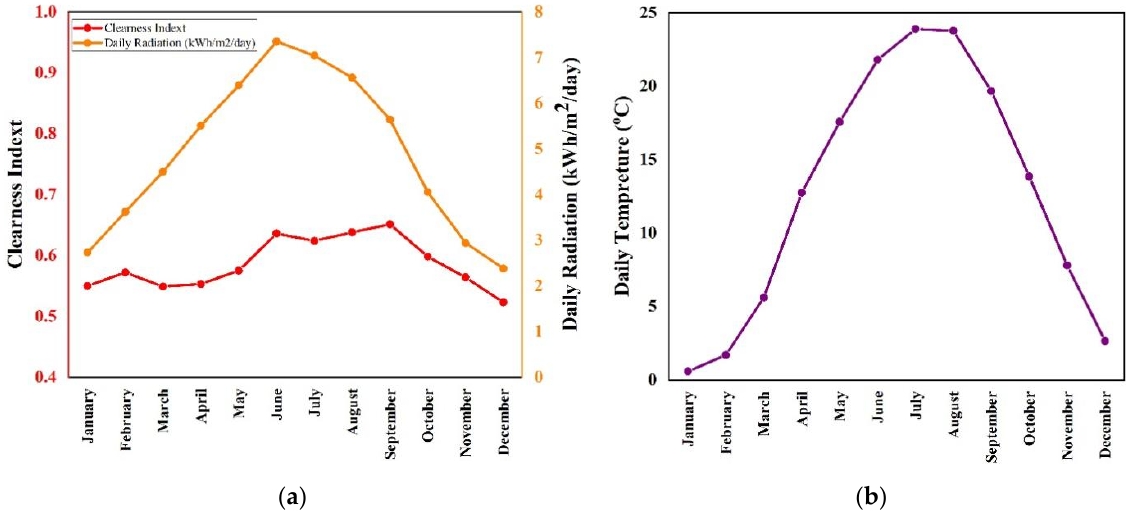
Figure 5. Meteorological data for the understudy location: ( a ) solar irradiance; ( b ) ambient temperature.